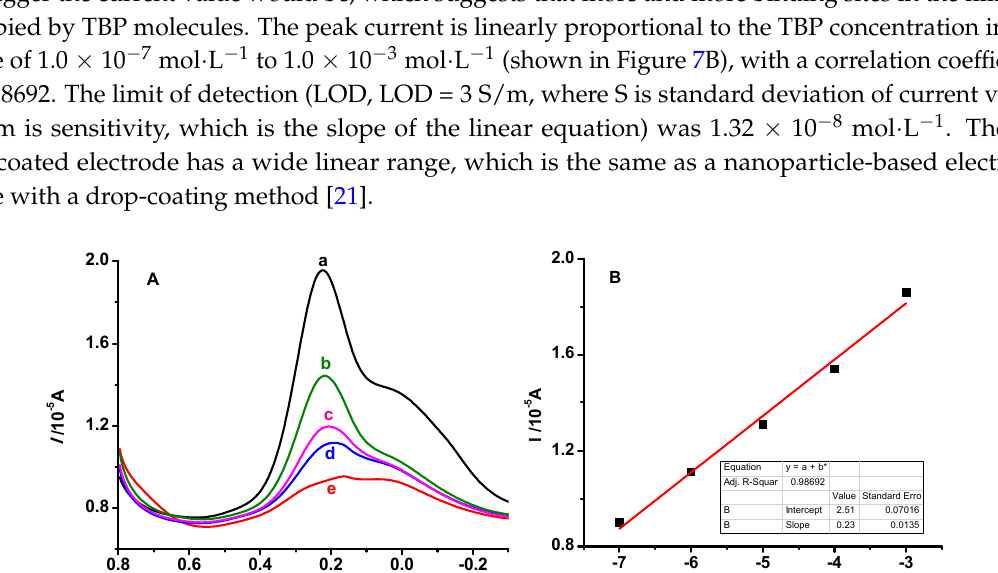
Figure 6. DPV of different sensors in 5.0 × 10 − 6 mol·L − 1 TBP with 0.3 mol·L − 1 KCl: ( a ) MIP/Au; ( b ) NIP/Au.